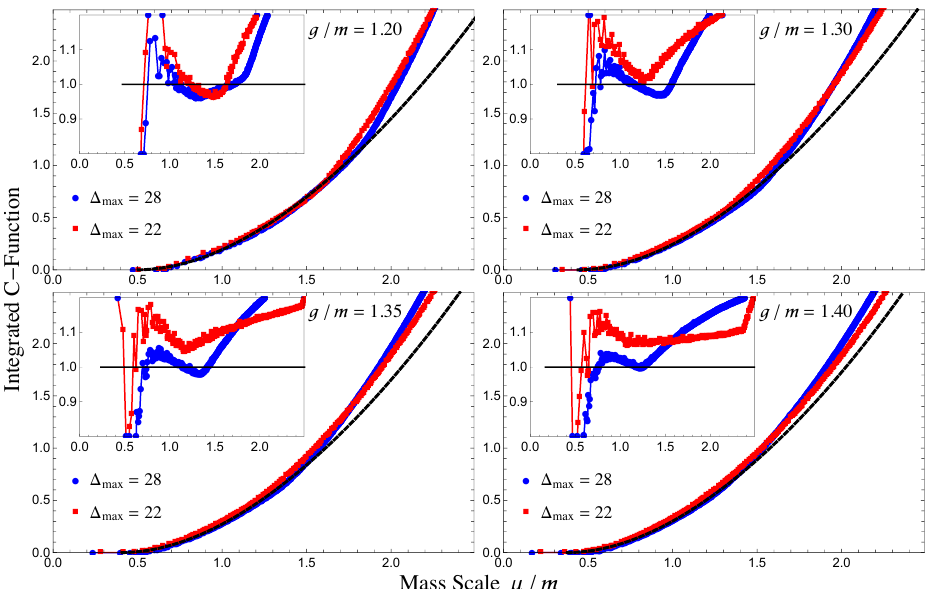
Figure 14 . Integrated C -function, as defined in eq. (C.2). Main plots: integrals of the truncation data and theoretical TIM prediction from figure 7. Insets: ratio of the truncation data at ∆ max = 28 (blue dots) and ∆ max = 22 (red squares) to the IR theoretical prediction (black line). The values of m gap for the theoretical prediction were determined by fitting to the data.